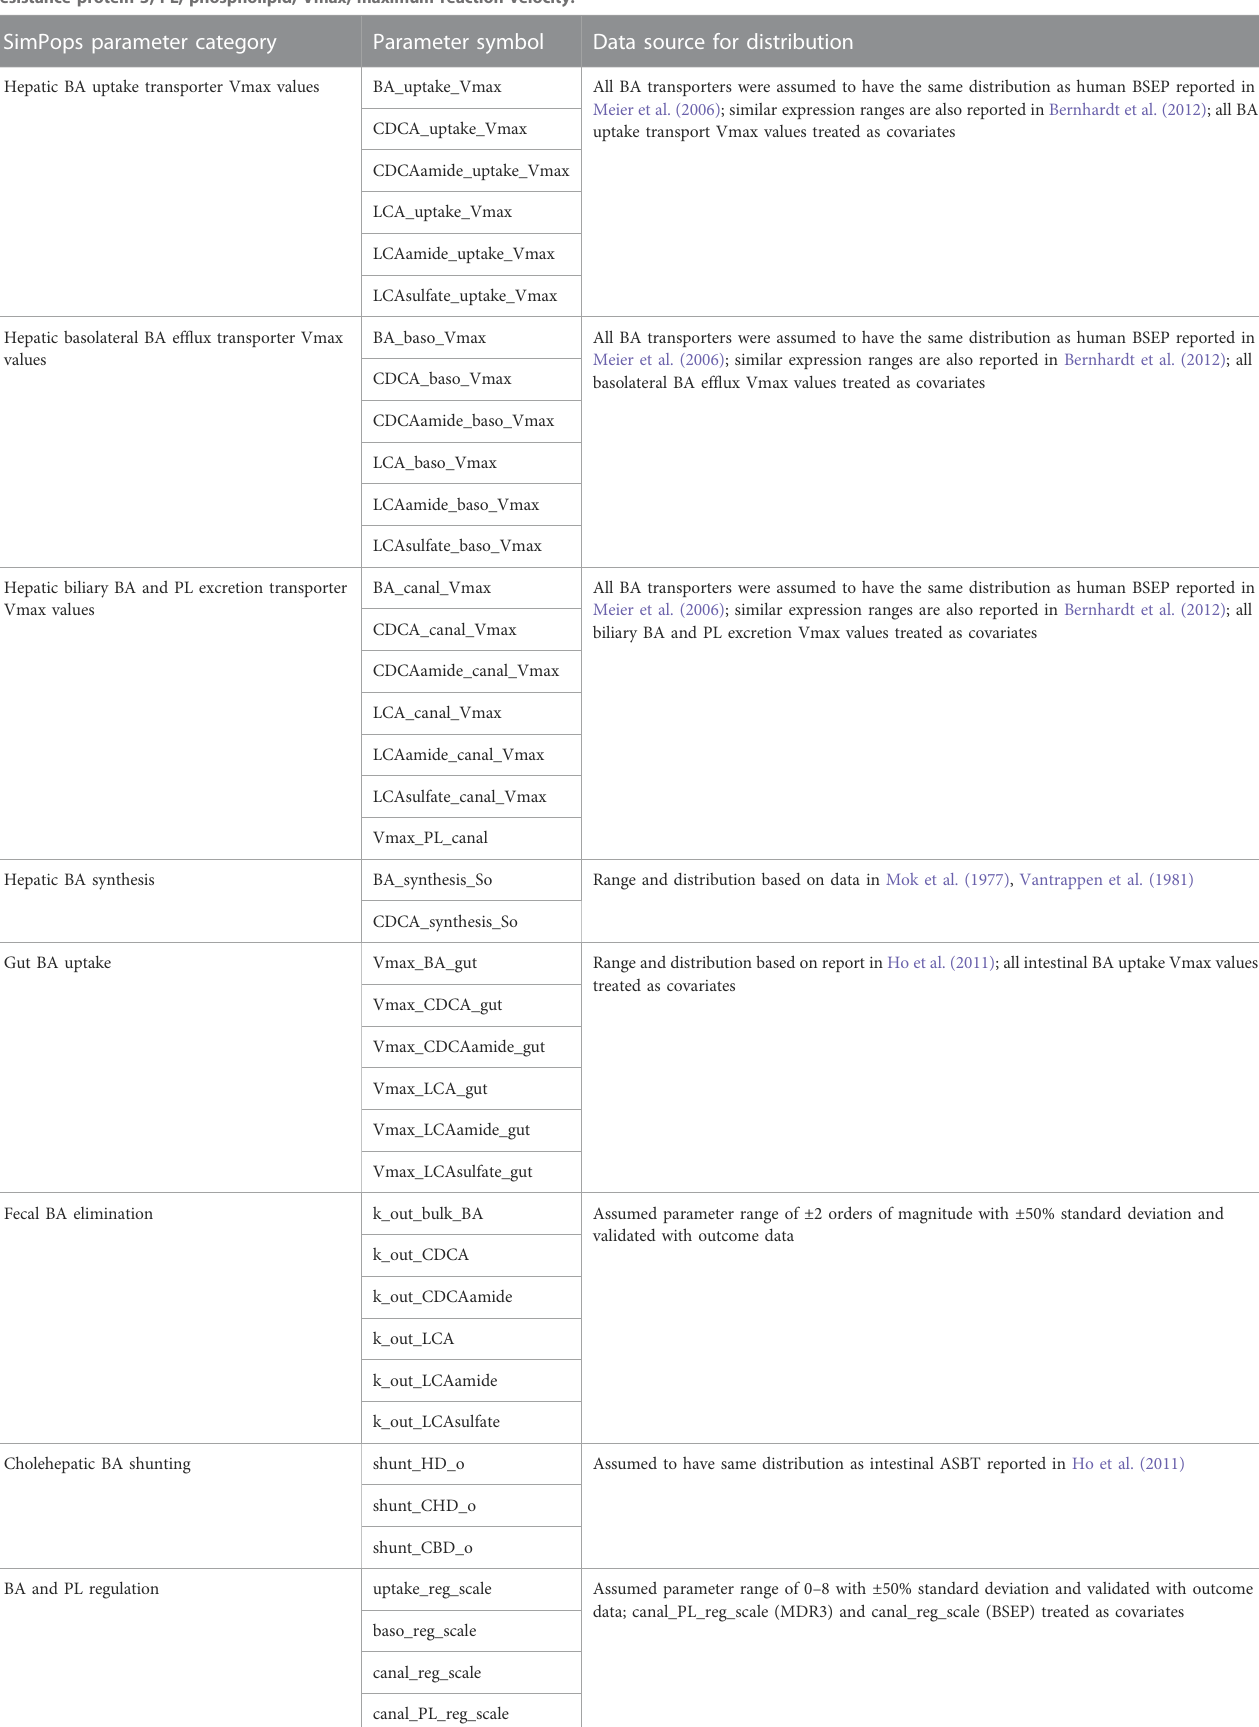
TABLE 1 Bile Acid and Phospholipid Toxicity Mechanism Parameters with Distribution of Values for Virtual Subjects in the Human_ROS_apop_mito_BA_chol_ v1 SimPops. ASBT, apical sodium – BA transporter; BA, bile acid; BSEP, bile salt export pump; CDCA, chenodeoxycholic acid; LCA, lithocholic acid; MDR3, multidrug resistance protein 3; PL, phospholipid; Vmax, maximum reaction